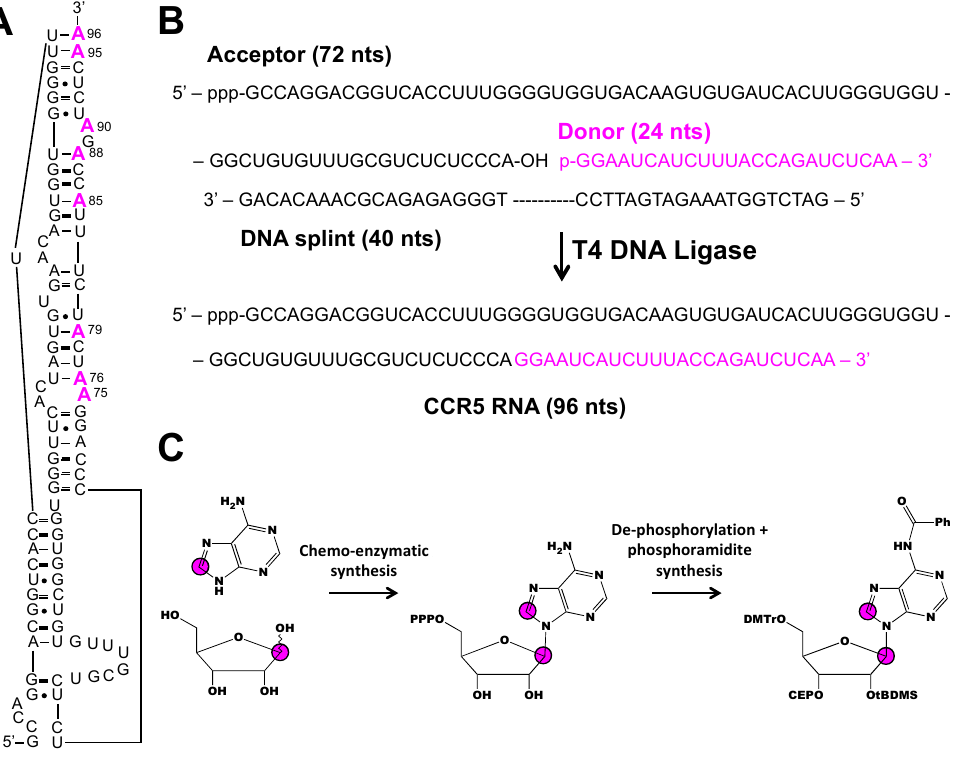
Figure 6. Combining chemo-enzymatic synthesis, chemical ligation, and phosphoramidite synthesis to make nucleobase and ribose isotope labeled CCR5 RNA [39]. ( A ) Secondary structure of the 96 nt CCR5 RNA. ( B ) Outline of ligation method. The unlabeled 72 nt acceptor fragment was made by in vitro transcription and the 24 nt donor fragment (colored in magenta) was made by solid-phase synthesis to incorporate individual [1 ′ ,8- 13 C 2 ]-adenosine labels, as shown in ( A ). ( C ) Schematic of the combined chemo-enzymatic synthesis and phosphoramidite synthesis to build the [1 ′ ,8- 13 C 2 ]-adenosine phosphoramidite. Magenta color indicates labeled residues, magenta circles refer to 13 C atoms, and Ph refers to phenyl group.